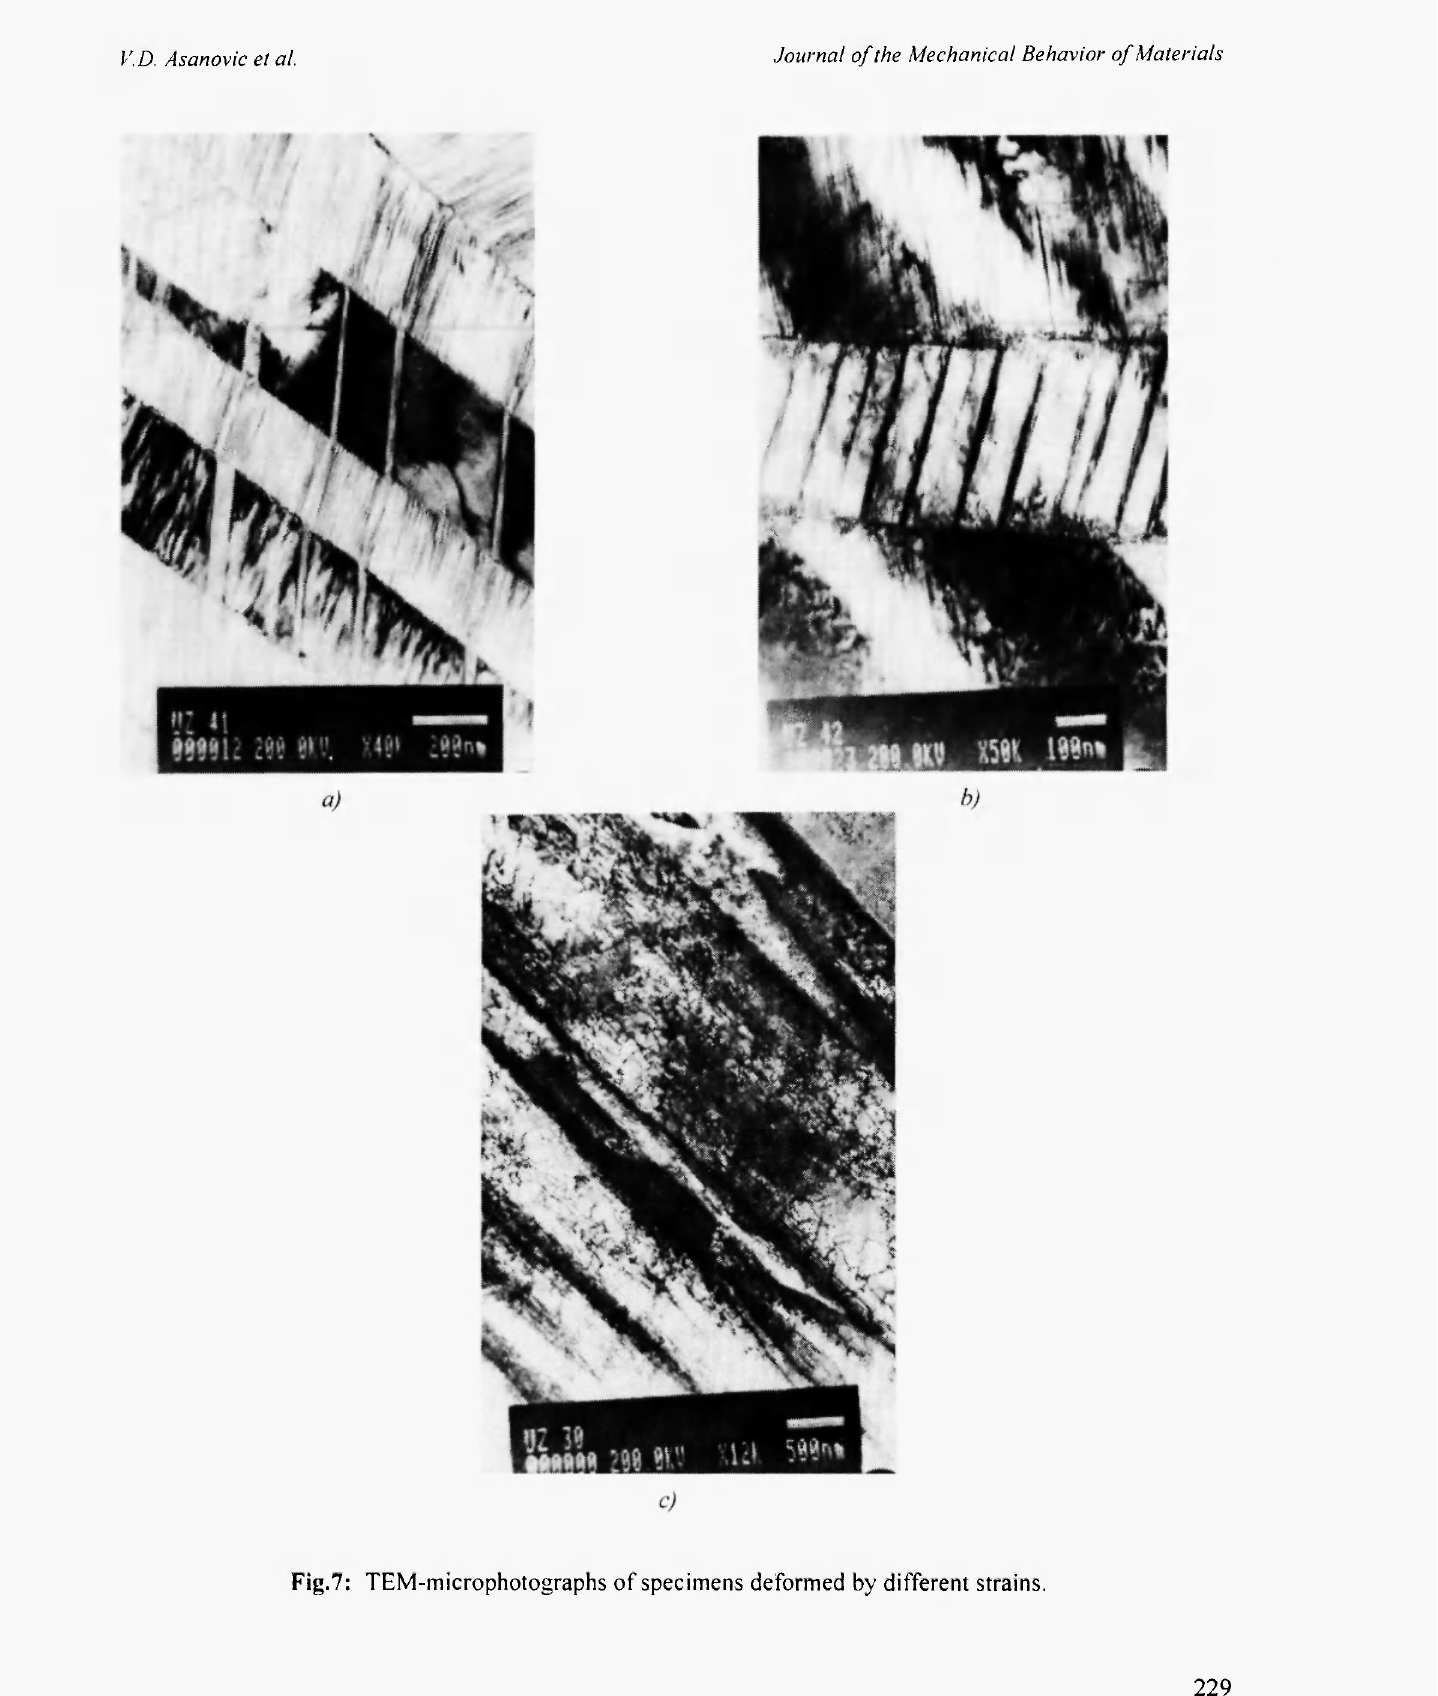
Fig .7: TEM-microphotographs of specimens deformed by different